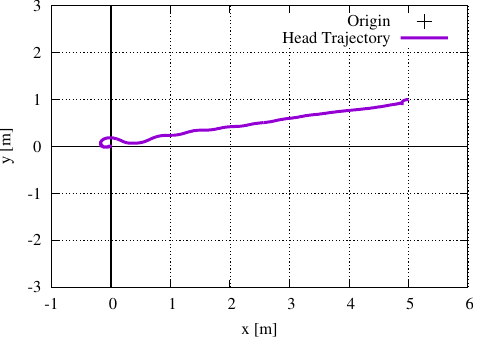
Figure 15. Case 2: Head